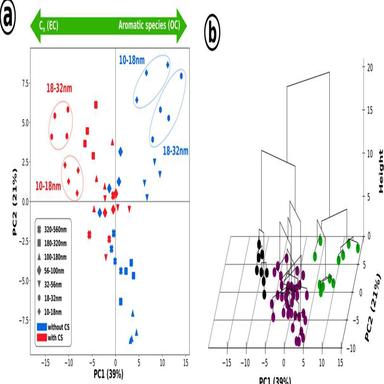
Impact of the CS on size-dependent PM chemical composition: a) Score plot of the first two principal components obtained from mass spectra of size-selected particles collected with (red symbols) and without (blue symbols) the CS in the HS engine regime; the arrows show the meaning of the principal components obtained from their loadings, and b) HCPC performed on the first five principal components (explaining more than 82% of the variance); three biggest clusters correspond to: small particles collected wit